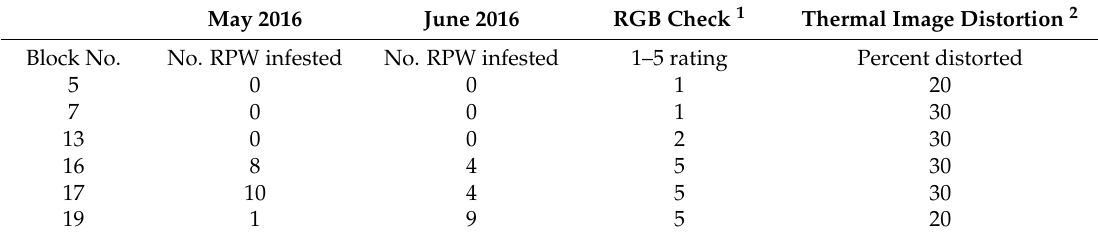
Table 2. Criteria used to determine the selection for the six test blocks.